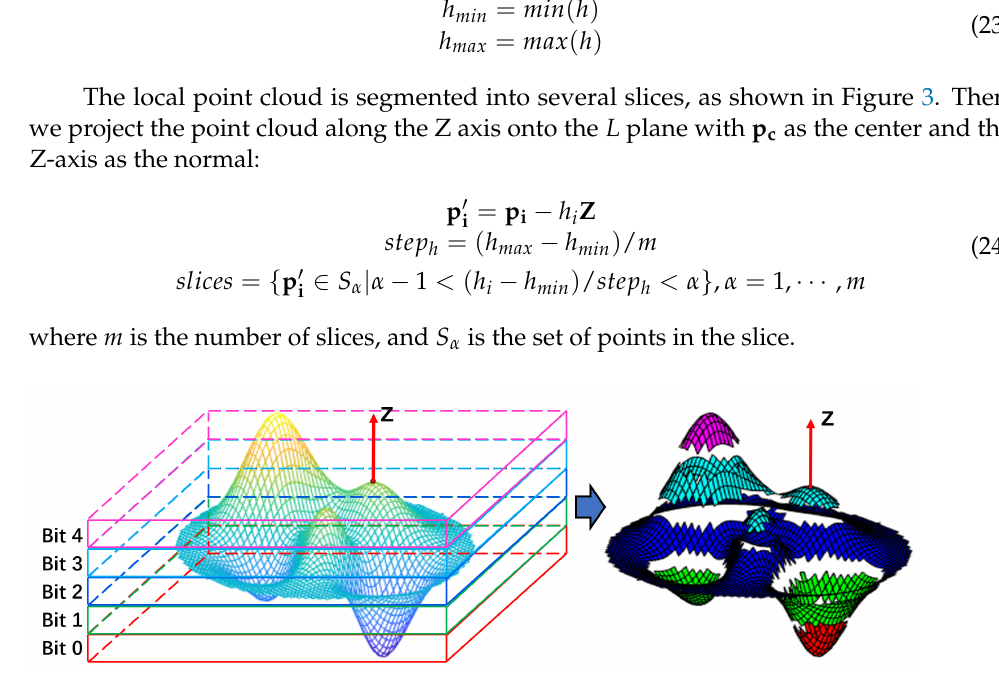
Figure 3. The schematic of the slice in the point cloud. The cubes with different colors on the left represent different slices, and the label of slices is the location of the binary; one the right is the surface after